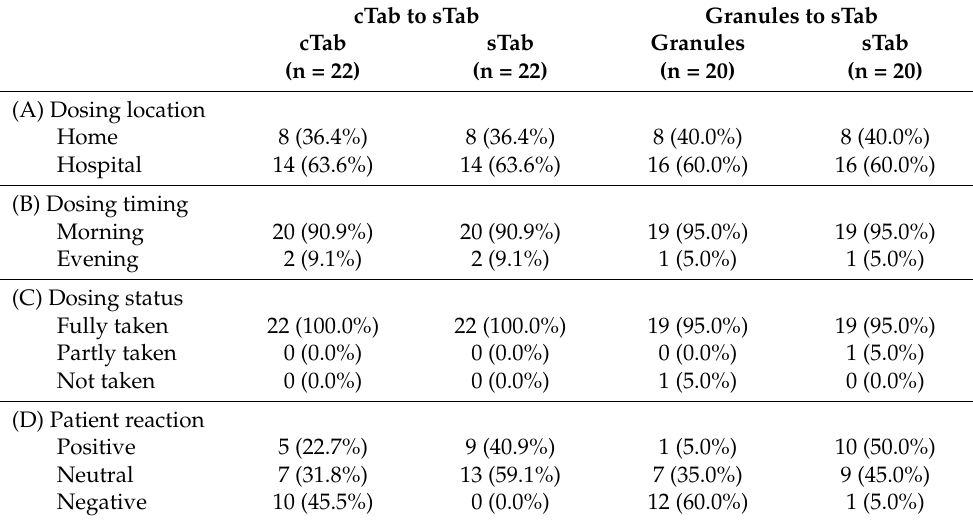
Table 3. Patient reactions at the time of dose.